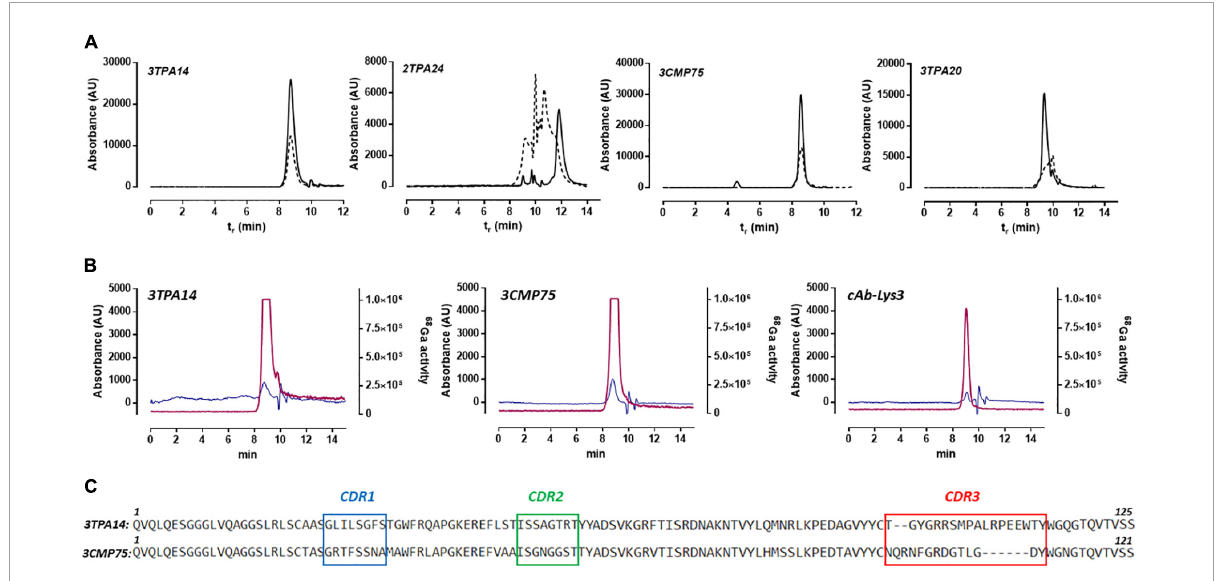
FIGURE3 High-performance liquid chromatography-size exclusion (HPLC–SEC) profiles of nanobodies. (A) Chromatograms of absorbance at 280 nM for the selected nanobodies (solid line) and conjugated with NOTA chelator (dashed line). (B) HPLC chromatograms of [ 68 Ga]Ga-NOTA-3TPA14, [ 68 Ga]Ga-NOTA-3CMP75, and [ 68 Ga]Ga-NOTA-cAb-Lys3 (non-specific) tracers; blue: 280 nM absorbance and red: activity of 68 Ga. (C) Amino acid sequences of the finally selected nanobodies 3TPA14 and 3CMP75. The CDR1, CDR2, and CDR3 are boxed in blue, green and red, respectively. The first and last amino acids are numbered above each